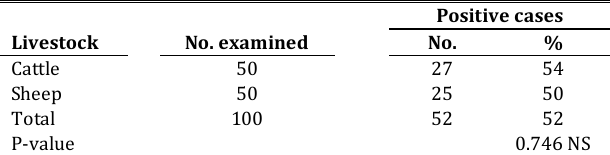
Table 1. Infection rate of Entamoeba spp in cattle and sheep as